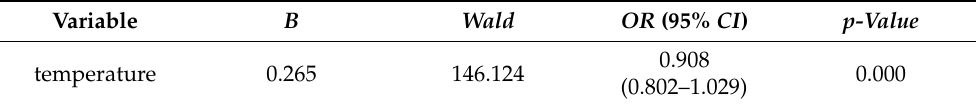
Figure 2. Effects of photoperiod on the development and reproduction of S. caerulea . ( a ) Number of eggs laid (the eggs were laid by two females during 24 h). ( b ) Parasitism rates. ( c ) Developmental duration. ( d ) Number of emerged adults. ( e ) Female ratio. ( f ) Adult life span. means ± standard errors, the different letters indicate significant differences amongst the photoperiods (female, capital letters; male, lowercase letters) ( p < 0.05), and * indicates significant differences between females and males at the same photoperiods ( p < 0.05). Table 4. Logistic regression analysis of the effect of photoperiod on S. caerulea ’s parasitism.